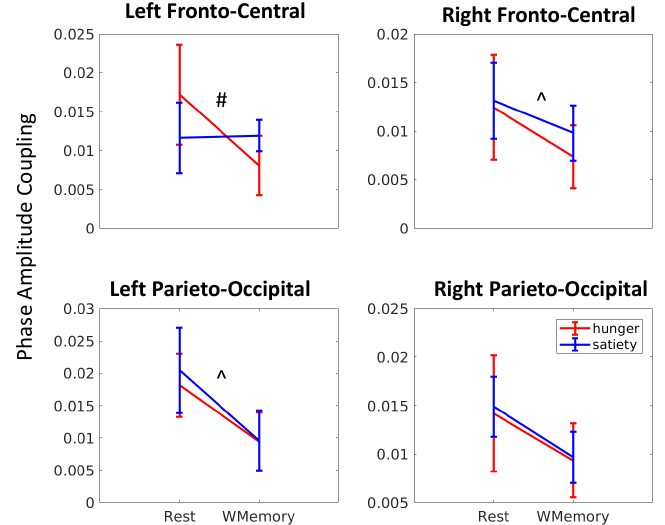
Figure 5. Phase amplitude gut ‐ brain coupling in four brain regions differs by cognitive state and gut satiety state. Significant cognitive state (resting versus working memory) based differences in PAC (marked with ^) are observed in the left fronto ‐ central (C3, F3), right fronto ‐ central (C4, F4), and left parieto ‐ occipital (P3, O1) regions. Modulations in the right parieto ‐ occipital (P4, O2) region were not significant. Specifically, the left fronto ‐ central region also showed significant (marked with #) hunger vs. satiety gut state effects, and significant cognitive state differences that vary with the levels of hunger (refer to Table 1 for statistical results).